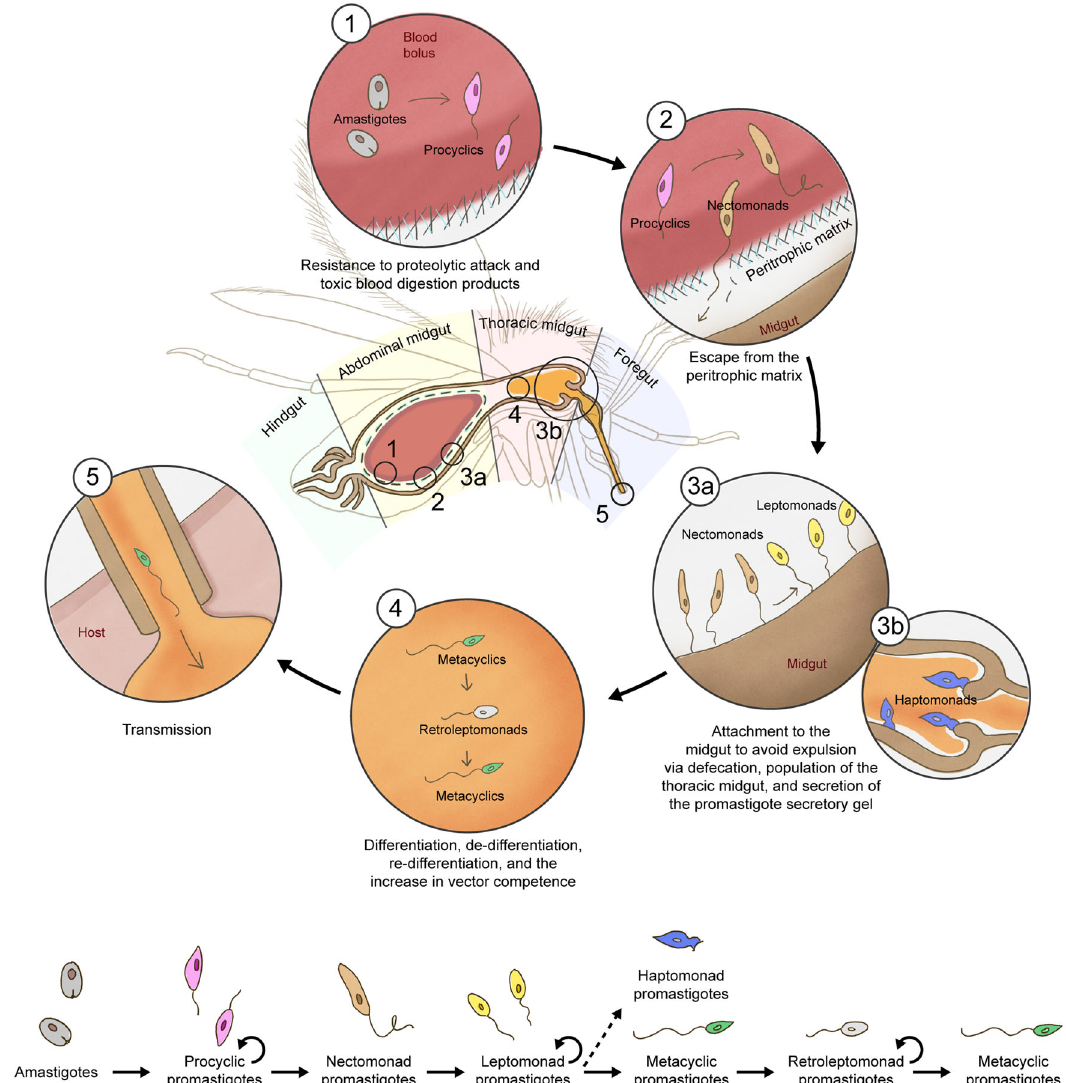
Fig. 3 Leishmania development within the sand fl y midgut. Schematic representation of the different forms of Leishmania parasites within the sand fl y vector and of the major barriers they must overcome to establish a productive infection — including the resistance to proteolytic attack/toxic byproducts of the digestion of blood (1), “ escape ” from the perothrophic matrix (2), attachment to the midgut to avoid expulsion (3a), attachment to (and impairment of) the stomodeal valve (3b), and (de-)differentiation and replication dynamics (4) — and ensure their transmission (5) to a new host. A linear life cycle with the different parasite forms within the vector is also represented; the circular arrows highlight the replicative parasite forms. Adapted from 60,86 . Courtesy